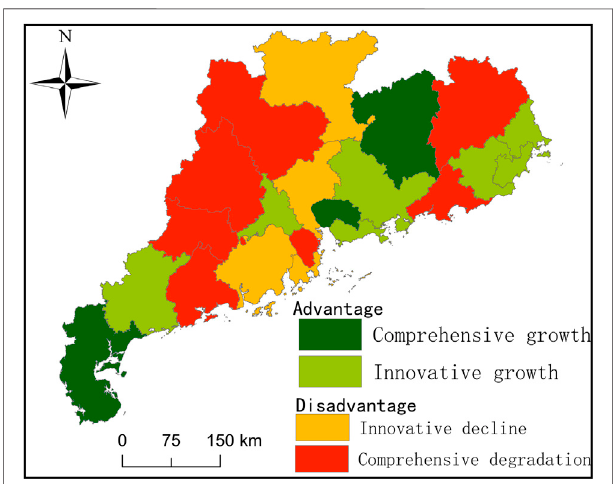
FIGURE 7 | Development of predicted WUE in Guangdong Province during 2019 – 2025.